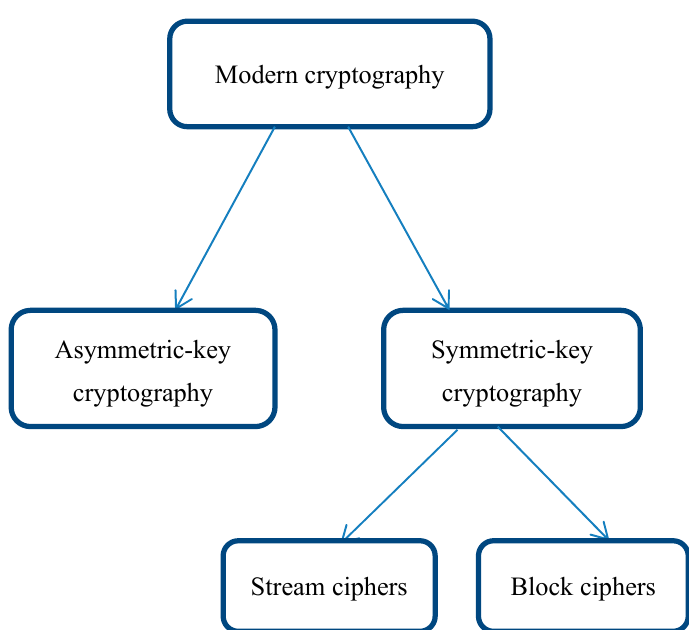
Figure 1. Main classification of a modern cipher.